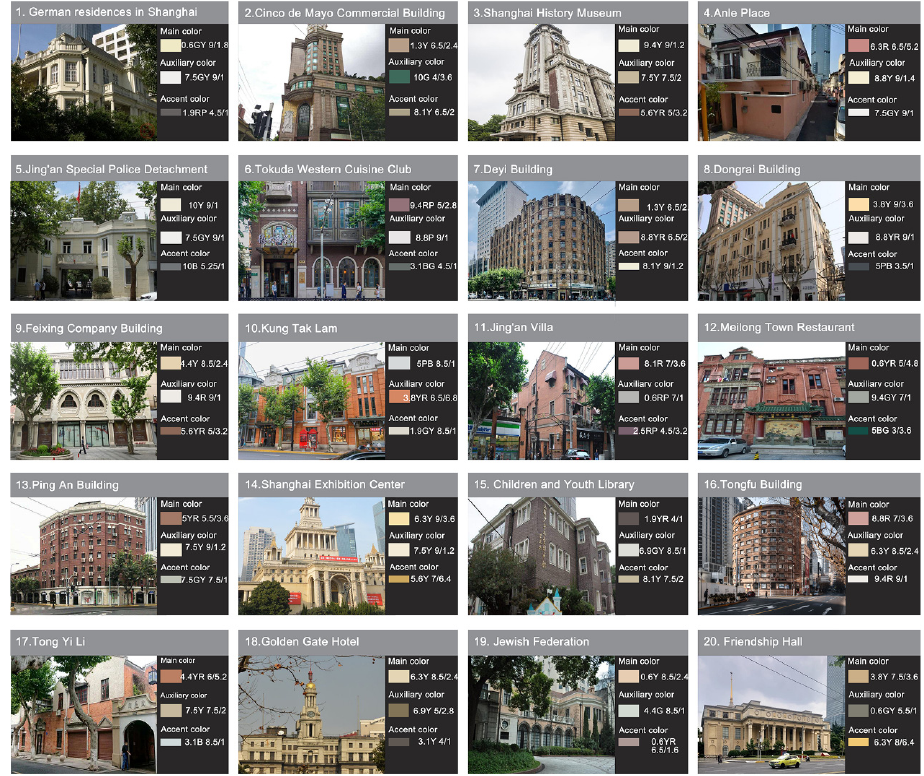
Figure 1. Summary diagram of the study of the color status of typical historical buildings on West Nanjing Road. (Source for the photos of the buildings: https://image.baidu.com (accessed on 11 April 2022)).